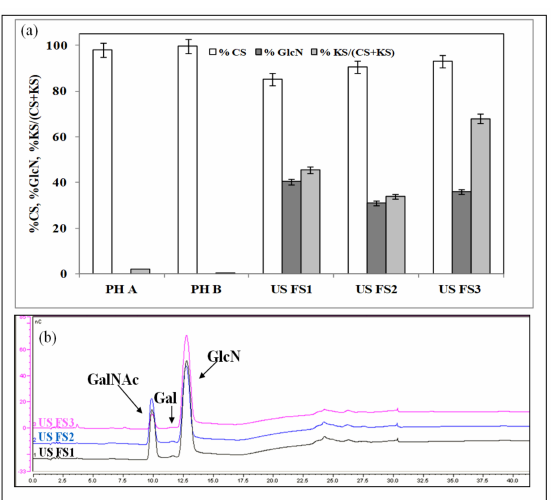
Figure 2. ( a ) CS, GlcN and KS contents in pharma grade samples and in US food supplements, obtained by HPAE-PAD analyses after chemical hydrolysis, reported in percentages compared to the declared values in the labels. ( b ) HPAE-PAD chromatograms of the US food supplements; the monosaccharide peaks are indicated by the